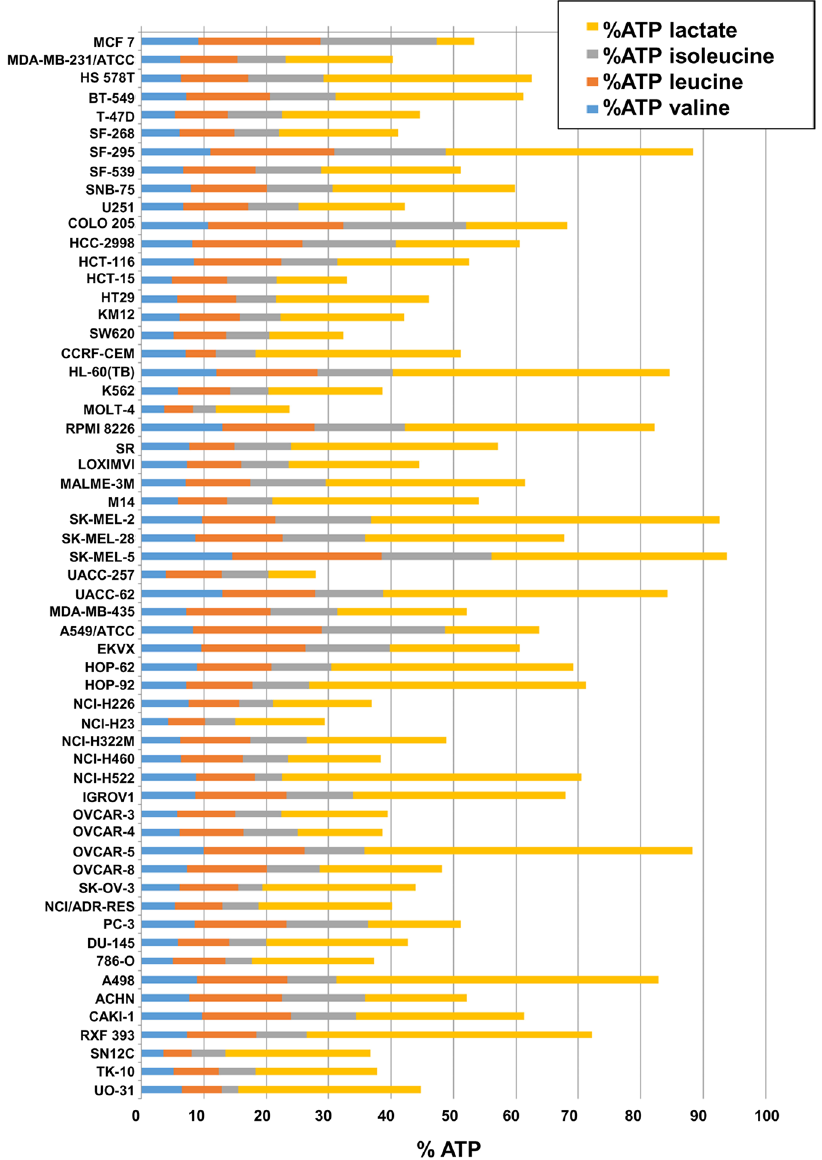
Figure 5. Estimated percentages of ATP obtained from lactic fermentation and valine, leucine, and isoleucine degradation for the NCI-60 cell